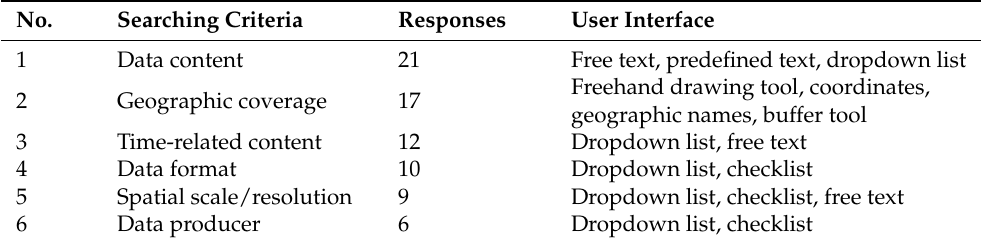
Table 6. Knowledgeable participants’ preferred interface for spatial data discovery.